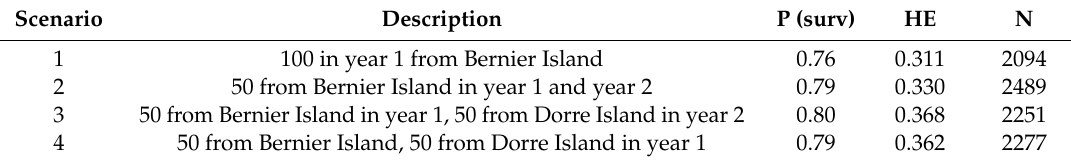
Table 5. Viability of a translocated L. fasciatus population after 50 calendar years, testing four scenarios. One hundred individuals translocated in one or over two years, including a drought with a mean frequency of one every 6.25 calendar years. Carrying capacity was set at 10,000 and scenarios were run for 1000